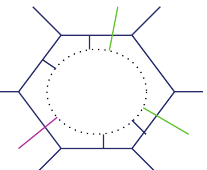
Figure 4: An arbitrary innermost blue cycle. The dotted line encapsulates the subgraph on the interior which may contain colors adjacent to